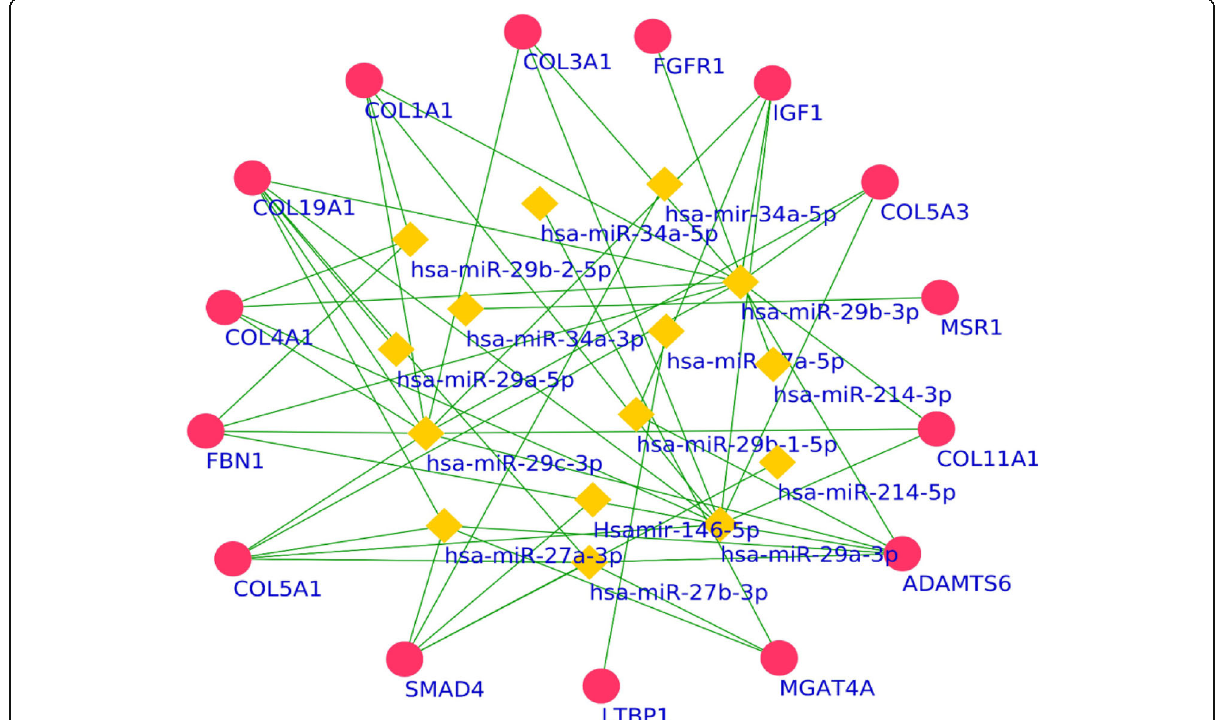
Fig. 5 Cluster of target genes (pink circle) with the microRNAs (yellow rhombus) and potential hub